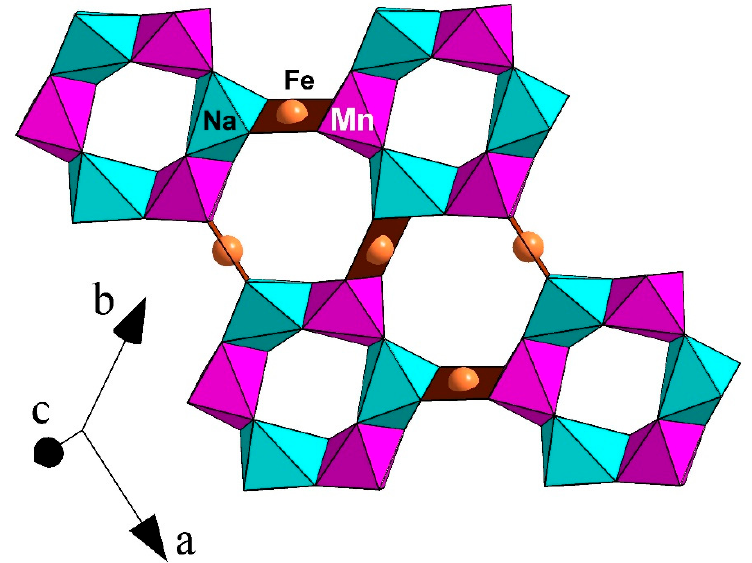
Figure 18. A fragment of the crystal structure of voronkovite [83].